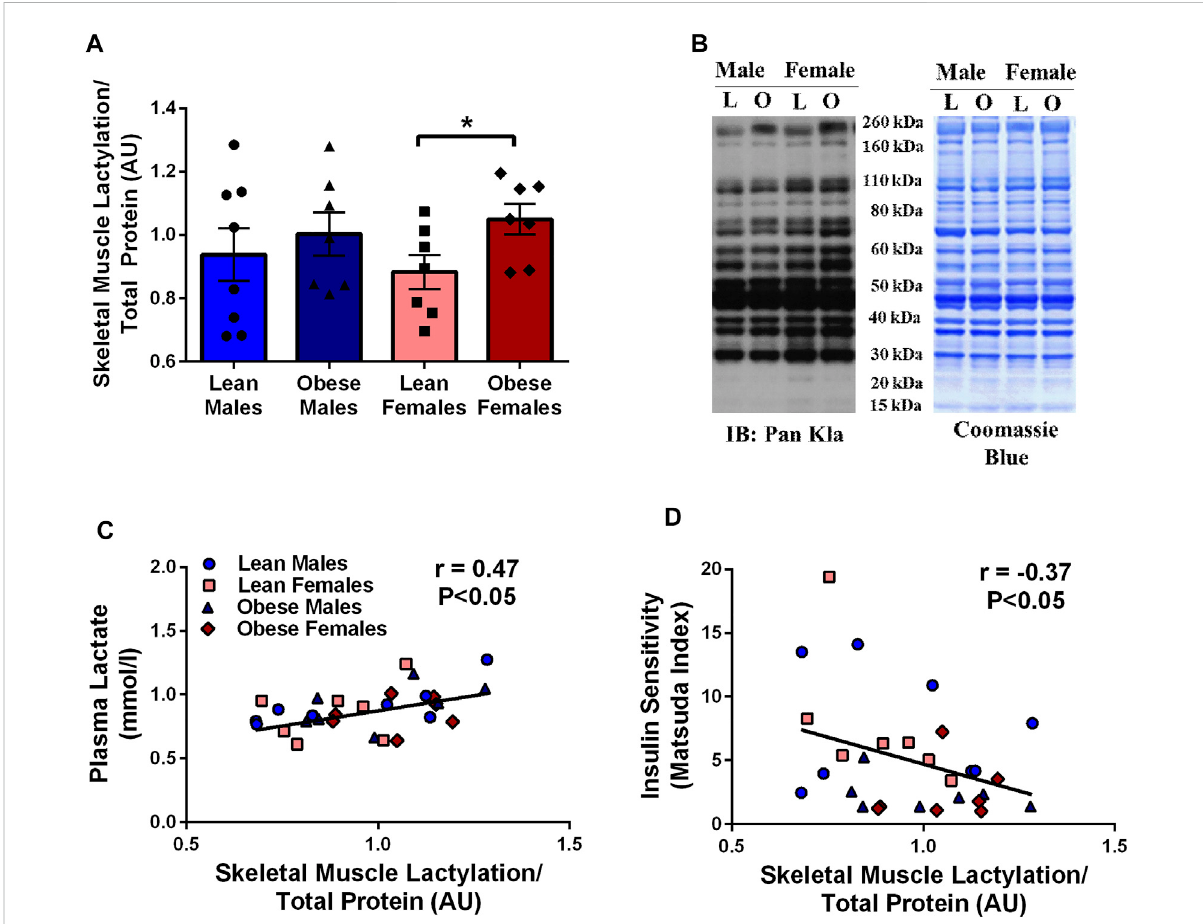
Skeletal Muscle Lactylation in Lean and Obese Individuals. Quanti fi cation of skeletal muscle lactylation in lean (male = 8, female = 7) and obese (male = 7, female = 7) individuals (A) . Skeletal muscle lactylation levels were normalized to Coomassie Blue (total protein) and presented relative to totalprotein.* p < 0.05vsleanfemales.Humanskeletalmusclerepresentativeblotforpan-klaandCoomassieblue (B) .Relationshipoffastingplasma lactate and skeletal muscle lactylation in the whole group (n = 29) (C) . Relationship of insulin sensitivity (Matsuda Index) and skeletal muscle lactylation in the whole group (n = 29) (D) . In all instances skeletal muscle lactylation levels were normalized to Coomassie Blue (total protein) and presentedinarbitraryunits(AU).Dataisexpressedasmean±SEM.Lightbluecirclesrepresentdatapointsforleanmales;lightpinksquaresrepresent data for lean females; dark blue triangles represent data points for obese males; dark pink diamonds represent data from obese